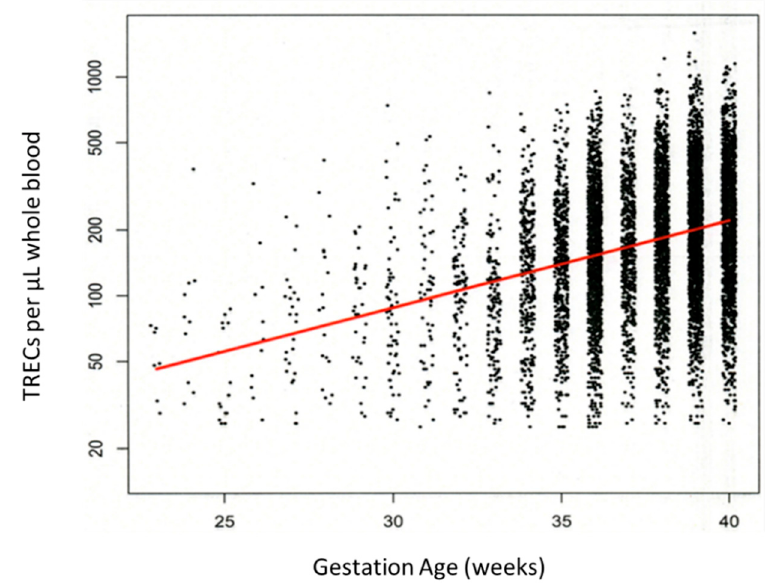
Figure 2. Plot of gestational age versus TRECs. The y -axis of the plot is in the log scale so that the linear regression line can be seen (red line). TREC copy numbers increase 9.6% per additional week of gestation with 95% CI of 8.95% to 10.25% ( p <